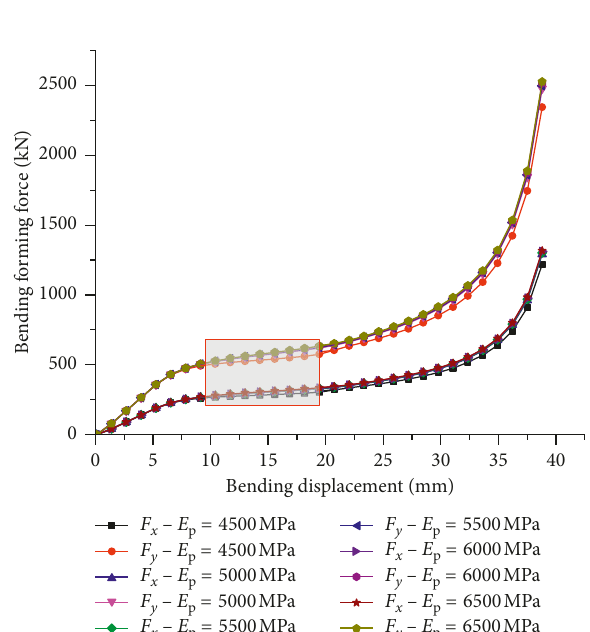
Figure 5: Effects of the yield strength on the bending load.